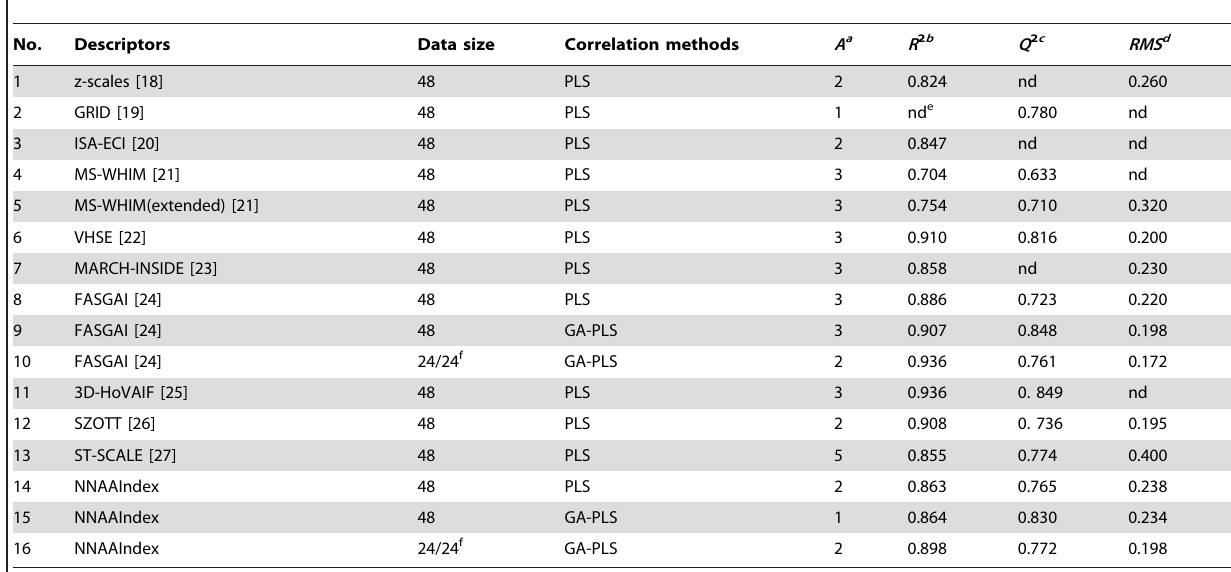
Table 3. The performance comparison among different QSAR models of